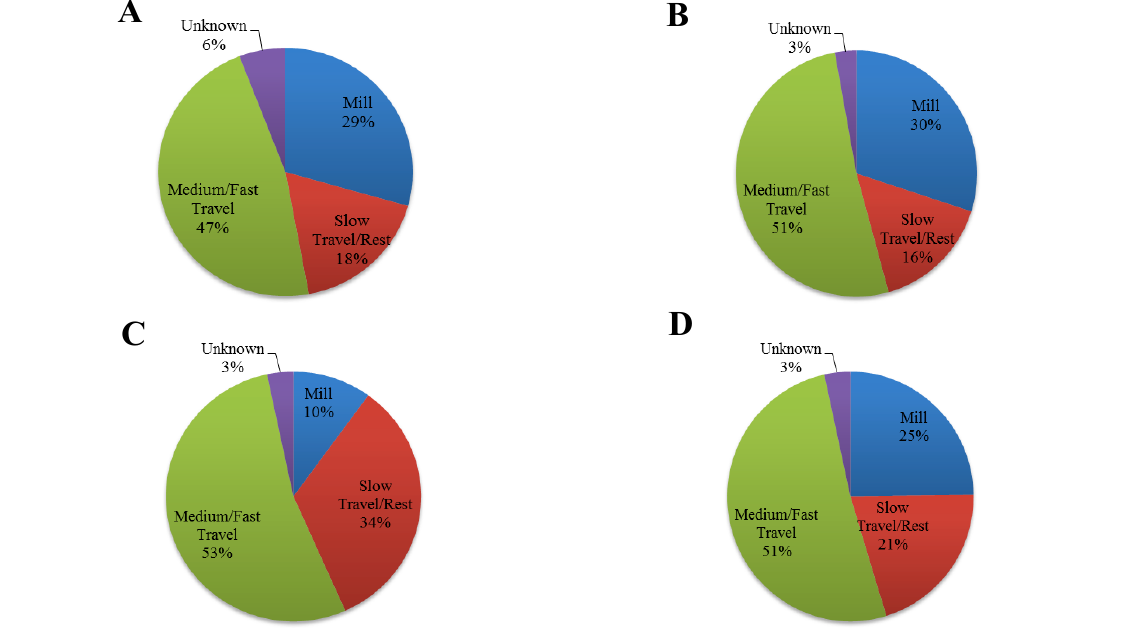
Figure 5. Behavior State by TOD for all blue whales combined: A. Activities during the “morning” (0801 – 1159), B. Activities during the “early afternoon” (1200 – 1559), C. Activities during the “late afternoon” (1500 – 1959), D. Activities during “all periods” (0801 – 1959).